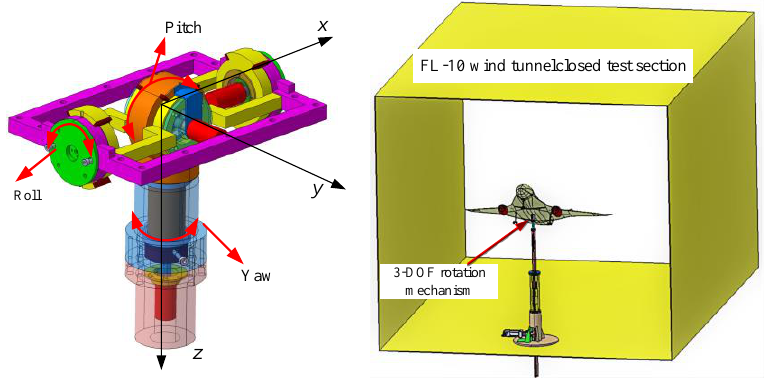
Figure 3. Schematic diagram of the three-axis rotating mechanism.